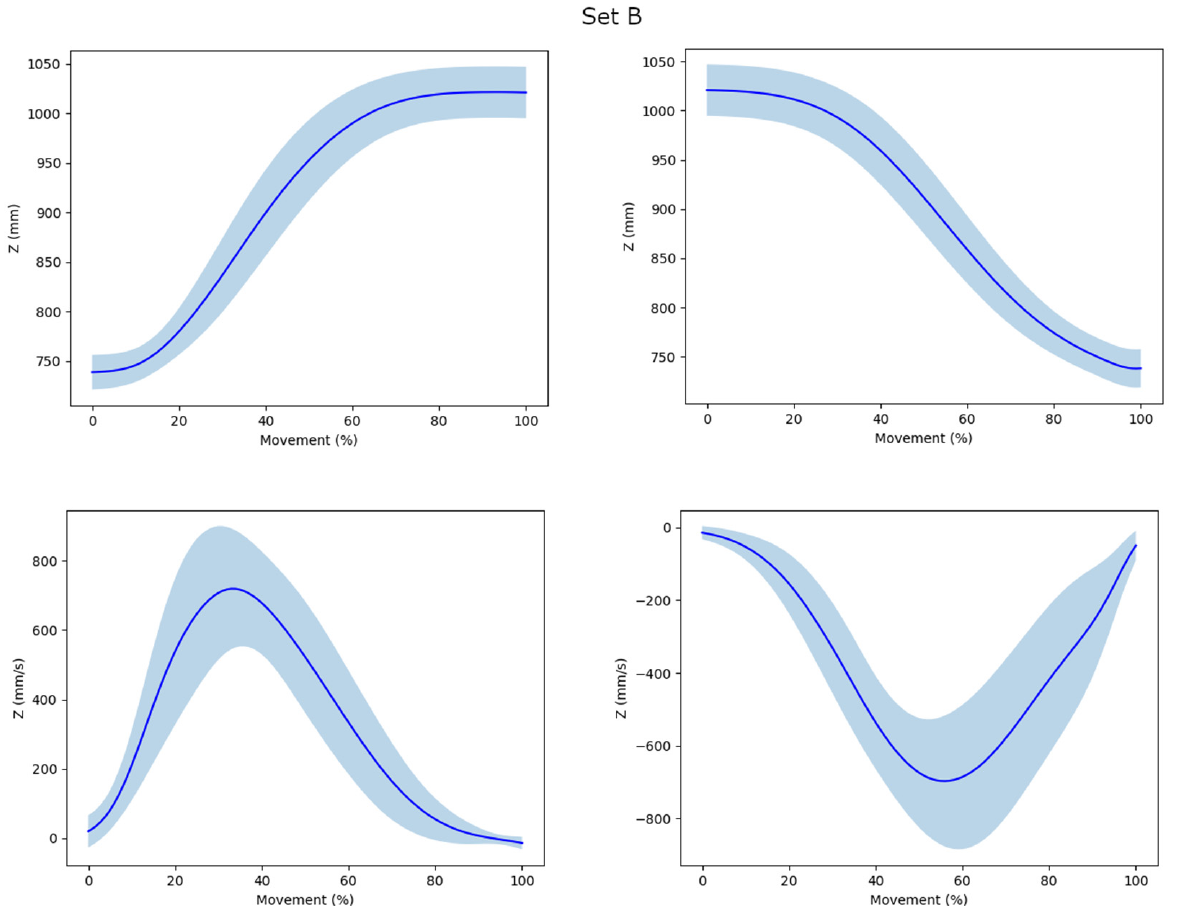
Figure 2. Mean value and standard deviation of trajectories (first line) and velocity profiles (second line) for set ( A ) (with pause) and set ( B ) (without pause) forward- and backward-pointing movements in the vertical plane (Z) as a function of movement completion (%).